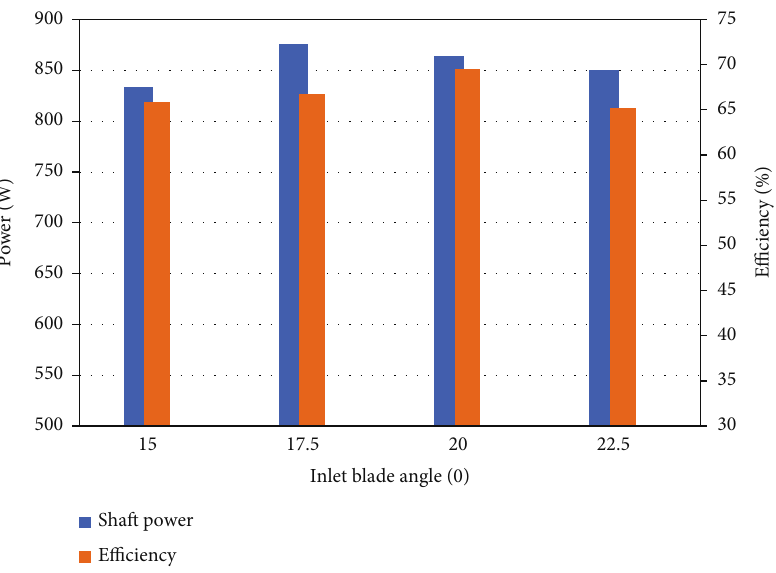
Figure 13: The in fl uence of the blade inlet angle on PAT power.